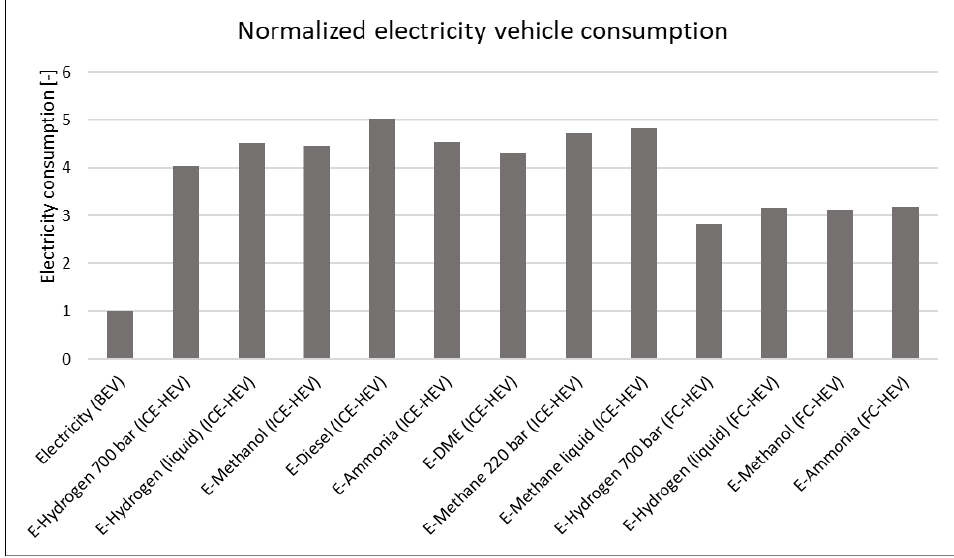
Figure 7. Normalised electricity consumption for average PC with respect to BEV. If we consider that grid electricity may carry a residual CO 2 -specific emission factor, especially during the next decades of transition, then less efficiency also means higher equivalent emissions. In Figure 8, equivalent vehicle emissions in gCO 2 /km are plotted versus the electricity emission factor: Solid lines represent powertrains and e-fuels currently ‘market ready’, while dashed lines indicate lower technology readiness. Electricity used in BEVs has the lowest CO 2 emission in any case, but it is important to note that e-fuels may cause emissions higher than current fossil fuels if electricity is not sufficiently decarbonised.